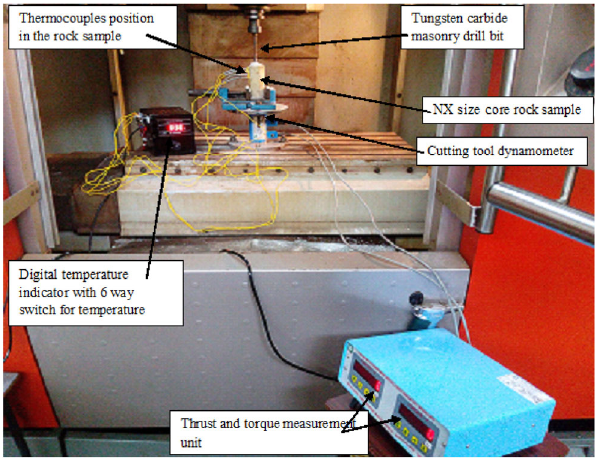
Fig. 1 Experimental set-up for temperature and thrust